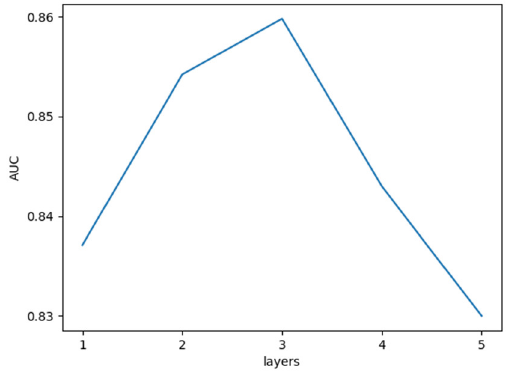
Figure 4. Parameter analysis of embedding layers.